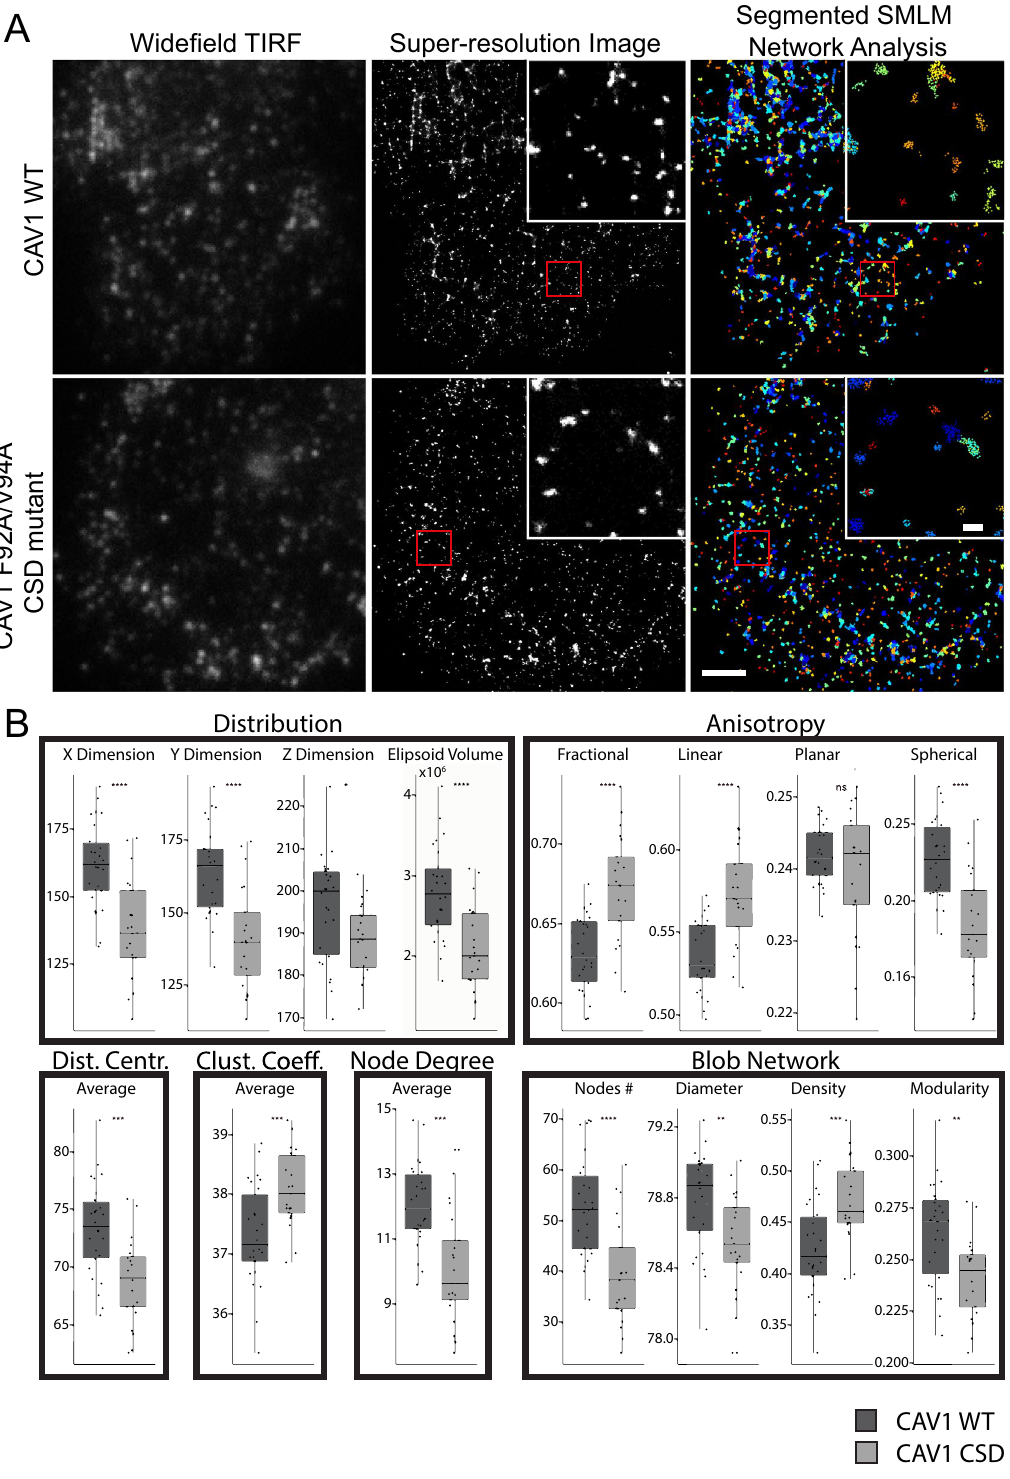
Figure 3. SMLM network analysis segments CAV1 clusters from SMLM data. ( A ) Representative TIRF wide- field imaging of CAV1 and SMLM GSD imaging of CAV1 in MC5 cells transfected with CAV1 WT or CSD mutant. 3D point clouds were processed with 3D SMLM Network Analysis 10 using iterative merging at 20 nm, filtering and segmentation to identify individual CAV1 blobs. Magnified SMLM and network analysis images of the boxed region highlights network analysis clusters (blobs) after processing. Scale bar, 2.5 µm; zooms, 250 nm. ( B ) Overall changes in features. Quantification of blob’s localizations distribution, anisotropy, localization’s distance to centroid, and blob’s network features between MC5 cells transfected with CAV1 WT or CSD mutant (n = 26 CAV1 WT cells, n = 21 CSD cells from four independent experiments; two-tailed unpaired t test; * p < 0.05; ** p < 0.01; *** p < 0.001; **** p < 0.0001). The rest of the global CAV1 features are shown in Supp. Fig